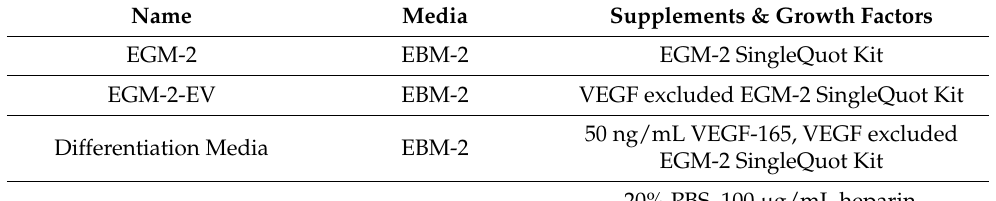
Table 2. Culture conditions for endothelial cells differentiated from porcine epiblast stem cells.